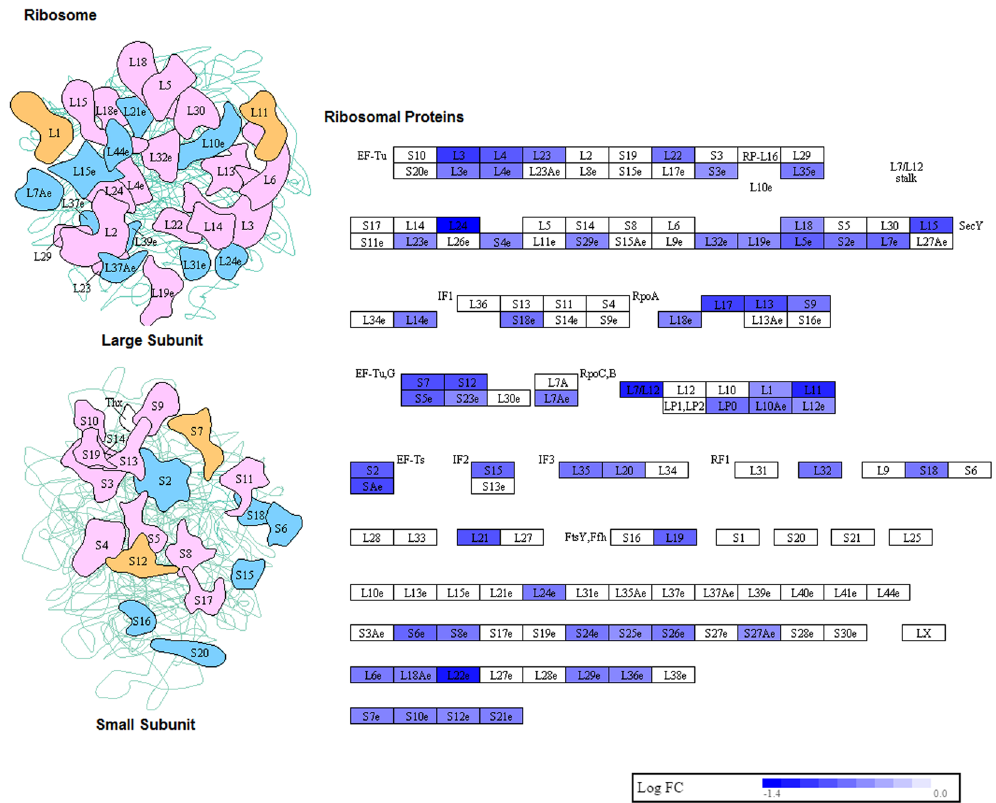
Figure 3. Downregulation of genes involved in ribosomal pathway in sarcoidosis monocytes. Graphic illustration of pathway analysis of DE (log 2 -fold change with FDR < 0.05) genes related to ribosome in sarcoidosis monocytes. The pathway diagram is overlaid with the computed perturbation of each gene. The perturbation accounts both for the gene’s measured fold changes and for accumulated perturbation propagated from any upstream genes (accumulation). The color intensity corresponds to the level of upregulation (red) or downregulation (blue) of the DE genes in sarcoidosis monocytes versus healthy monocytes. Note: A number of genes encoding large and small ribosomal subunits were